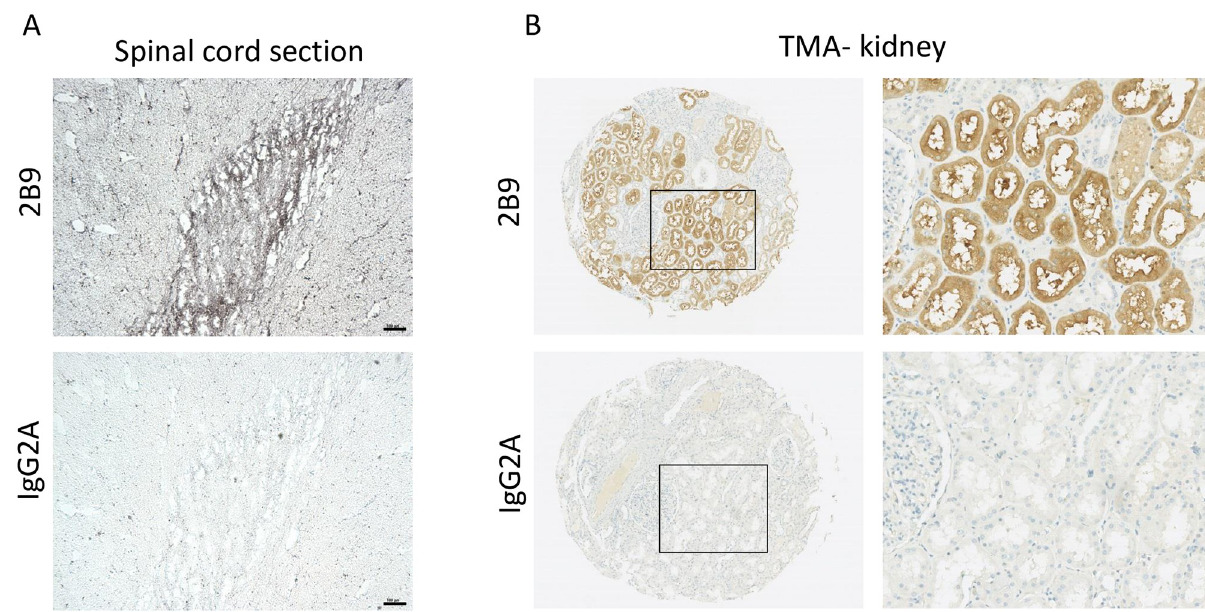
Fig 10. S1P 1 is expressed in human tissues. S1P 1 is expressed in human spinal cord. Immunohistochemistry was performed in frozen human spinal cord sections using 2B9 and control IgG2A antibodies as described in methods section. Scale bar, 100 μ m. A, S1P 1 is expressed in human kidney. Immunohistochemistry was performed in human TMA kidney samples using 2B9 and control IgG2A antibodies (1:50, w/v) as was previously described [23]. Right panel shows 2mm TMA kidney sections, left panel shows X20 magnification.